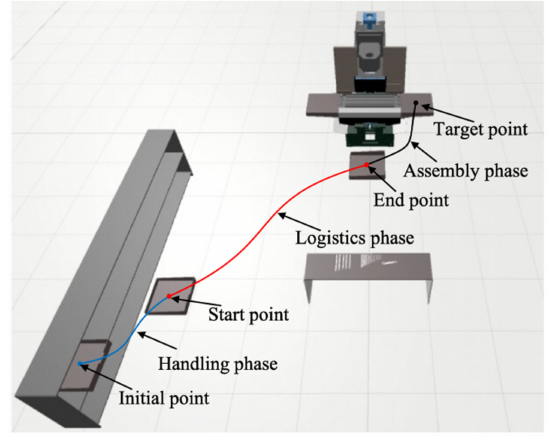
Figure 1. Segmentation of an assembly path.